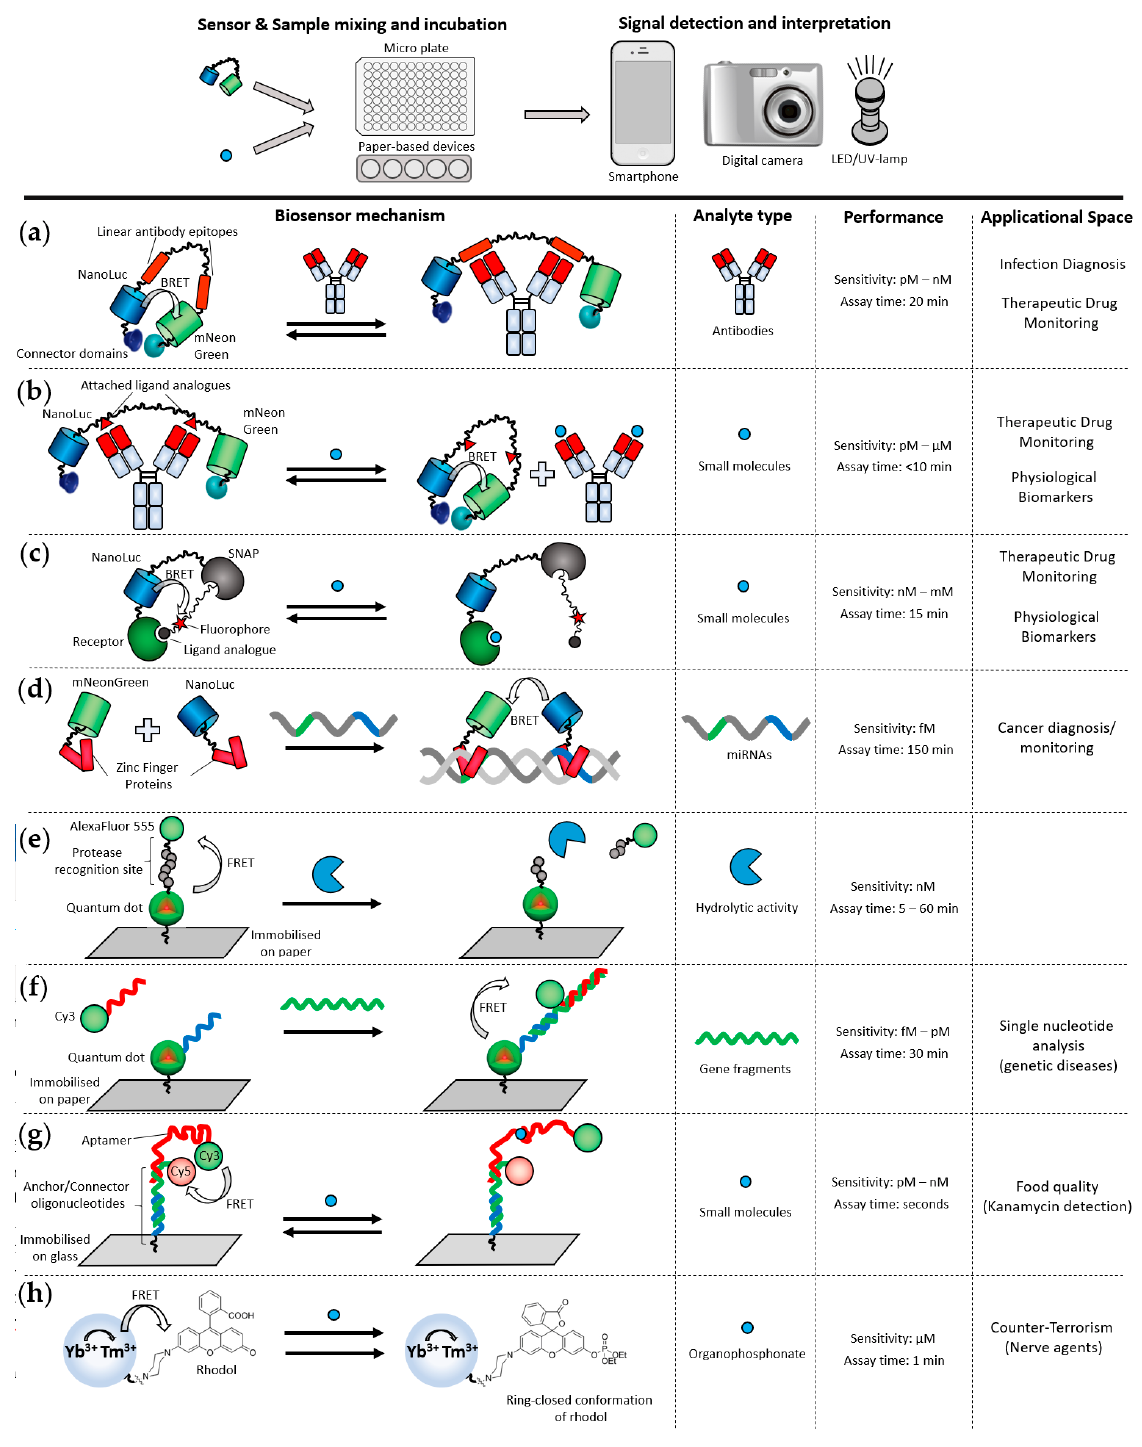
Figure 4. Examples of PON-suitable applications using a digital camera or smartphone in combination with micro plates or paper-based devices. BRET-based biosensors are spotted on paper-based analytical devices (PADs), and signals are recorded with a digital camera or smart phone. FRET biosensors require an additional source of excitation, such as a light-emitting diode (LED) or UV-lamp. ( a ) LUMABS biosensors (LUMinescent AntiBody Sensor) are comprised of the luciferase NanoLuc and the fluorescent protein mNeonGreen connected through a linker containing linear epitopes for antibodies of interest. In the absence of the antibody of interest, NanoLuc and mNeonGreen dimerize through the connector domains [73,74,78]. ( b ) LUMABs were modified by replacing linear epitopes with unnatural amino acids acting as a chemical handle to introduce analogues of analytes of interest. An antibody binding to these analogues is introduced, separating NanoLuc and mNeonGreen. In the presence of the analyte, antibodies preferentially bind to the analyte instead of its analogues incorporated in the LUMAB biosensor [77]. ( c ) LUCIDs (luciferase-based indicators of drugs) are